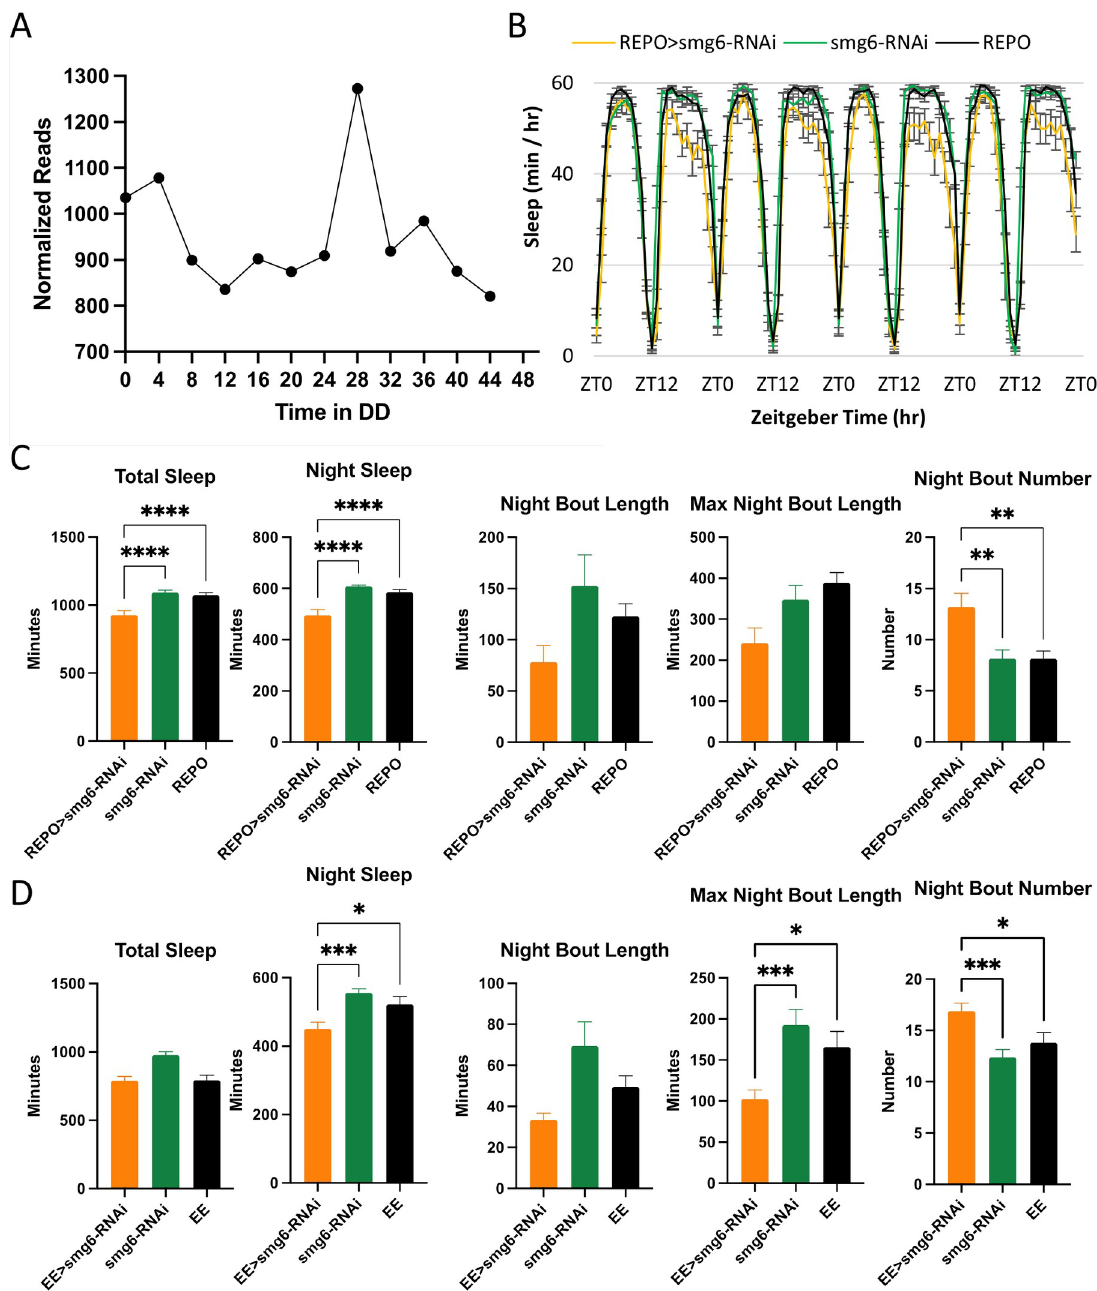
Fig 3. Smg6 is required for normal night sleep. A) Normalized read count across two days in DD derived from the astrocyte TRAP. Results are averages of two data sets per time point. B) Average sleep behavior across four days for REPO > SMG6-RNAi (orange, n = 23), SMG6-RNAi (green, n = 25), and REPO (black, n = 32). C) Average total sleep, night sleep, night bout length and night bout number for REPO (pan-glial) experiments. Results are mean ± SEM, One-way ANOVA, �� p < 0.01, ���� p < 0.0001. D) Average total sleep, night sleep, night bout length, and night bout number for EE (astrocyte) experiments. Results are mean ± SEM, One-way ANOVA, � p < 0.05, ��� p <